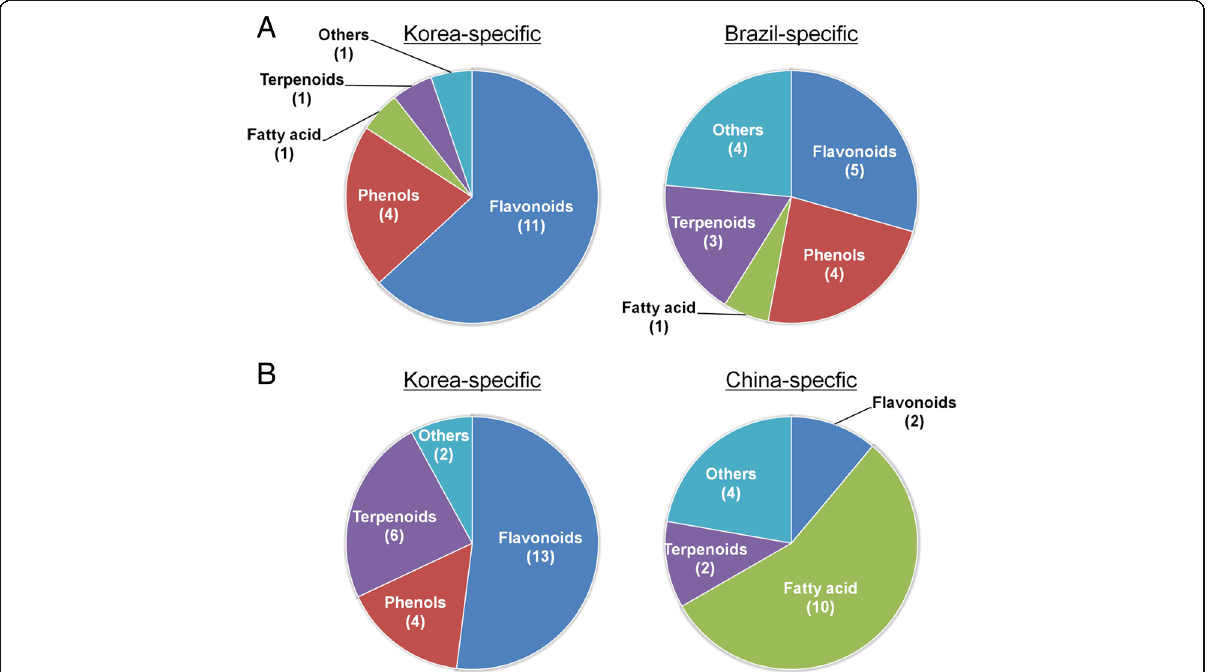
Fig. 4 Pie charts showing compositional differences of key components discriminating a Korean and Brazilian propolis and b Korean and Chinese